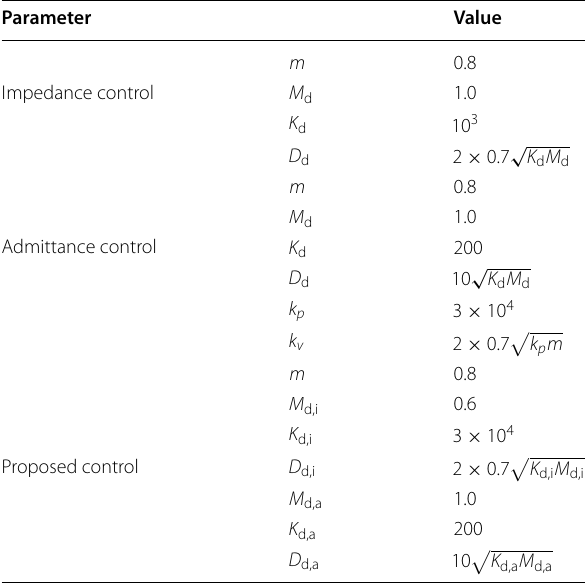
properties of each controller for